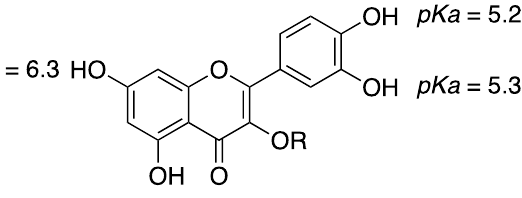
Figure 2. Jaguar-predicted pKa values for the three acidic hydroxyl groups of the quercetin moiety. R represents the rutin glycon.